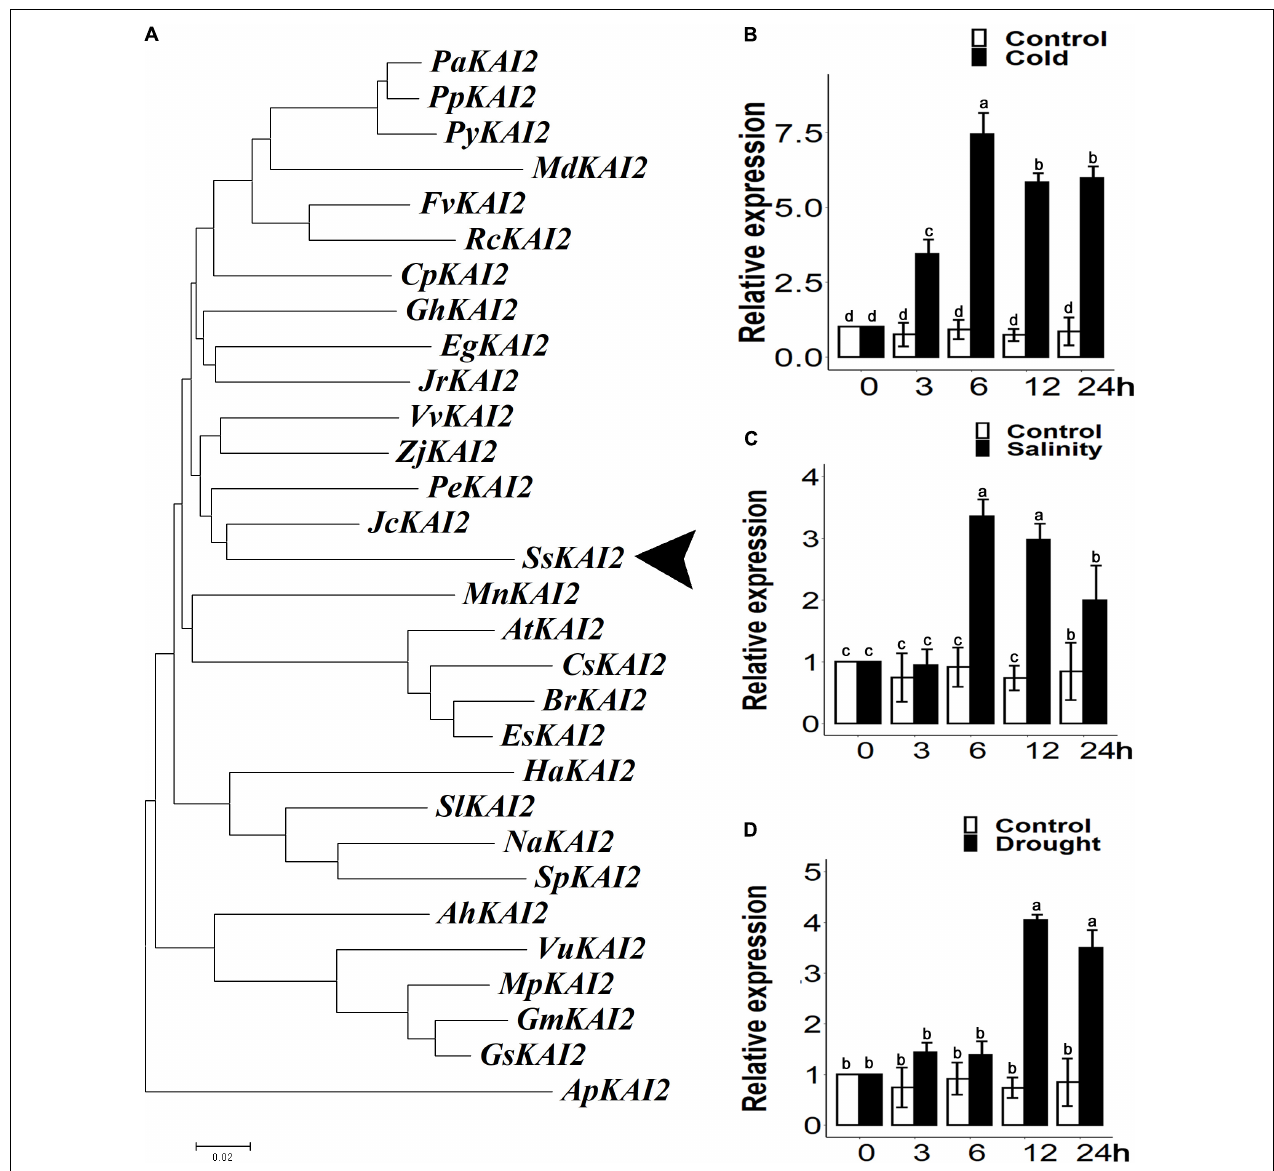
FIGURE 1 | Phylogenetic analysis and relative expression of KAI2 in Sapium sebiferum under cold, salinity, and osmotic stresses. (A) Phylogenic analysis of SsKAI2 protein with its homologs from other species. (B) SsKAI2 relative expression under cold (4 ◦ C), salinity (200 mM NaCl) (C) , and osmotic stress (300 mM mannitol) (D) . Twenty-five-day-old seedlings were used to determine the SsKAI2 expression level under abiotic stresses. Leaf samples were collected after 3 − , 6 − , 12 − , and 24 h of each treatment. Sapium sebiferum UBQ10 was used as a reference gene; control treatment at 0 h was considered as 1. qPCR was used to determine gene expression, one-way ANOVA was used to analyze all data, and HSD Tukey’s test was used to perform multiple comparisons at P < 0 . 05 significant level ( n = 3). Bars with uncommon letters show significant difference at P < 0 . 05